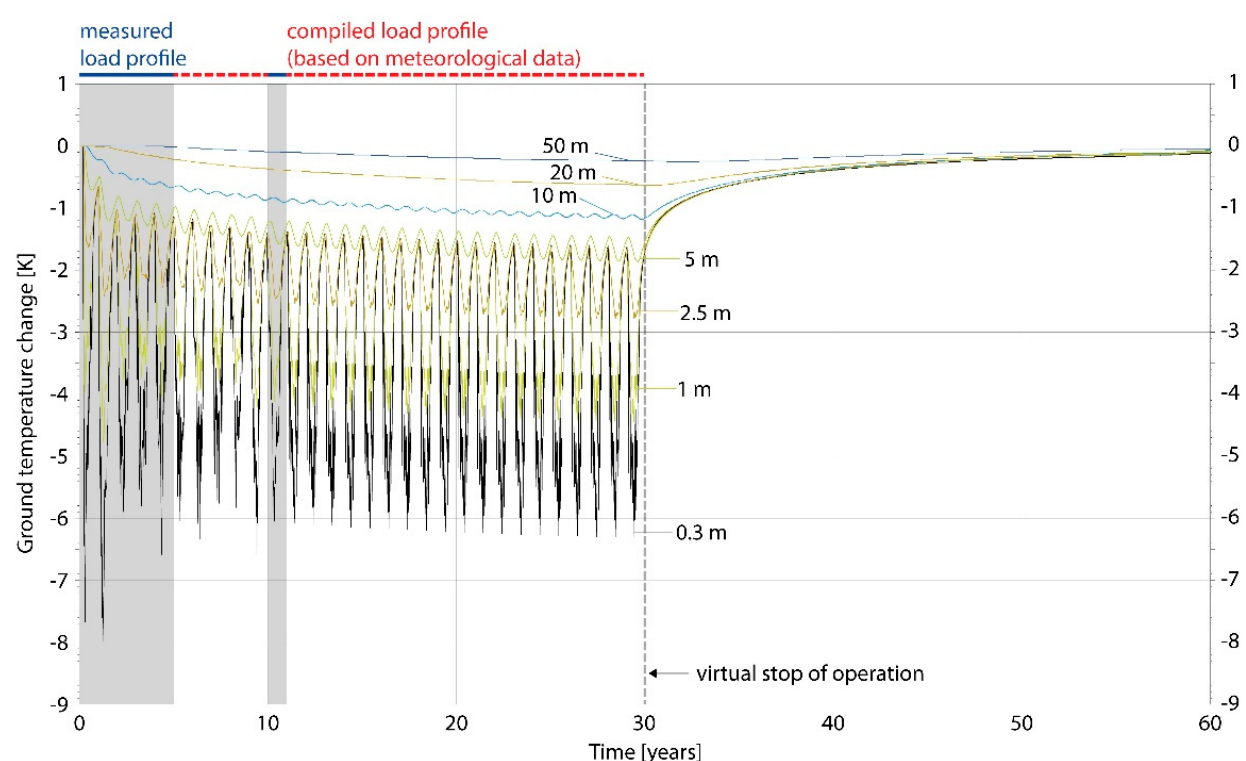
Figure 9. Measured and model-simulated ground temperature changes at 50 m depth around the BHE at Elgg at various distances, over 30 years of operation and 30 years of recovery. Data from [9] are plotted. For details, see text.